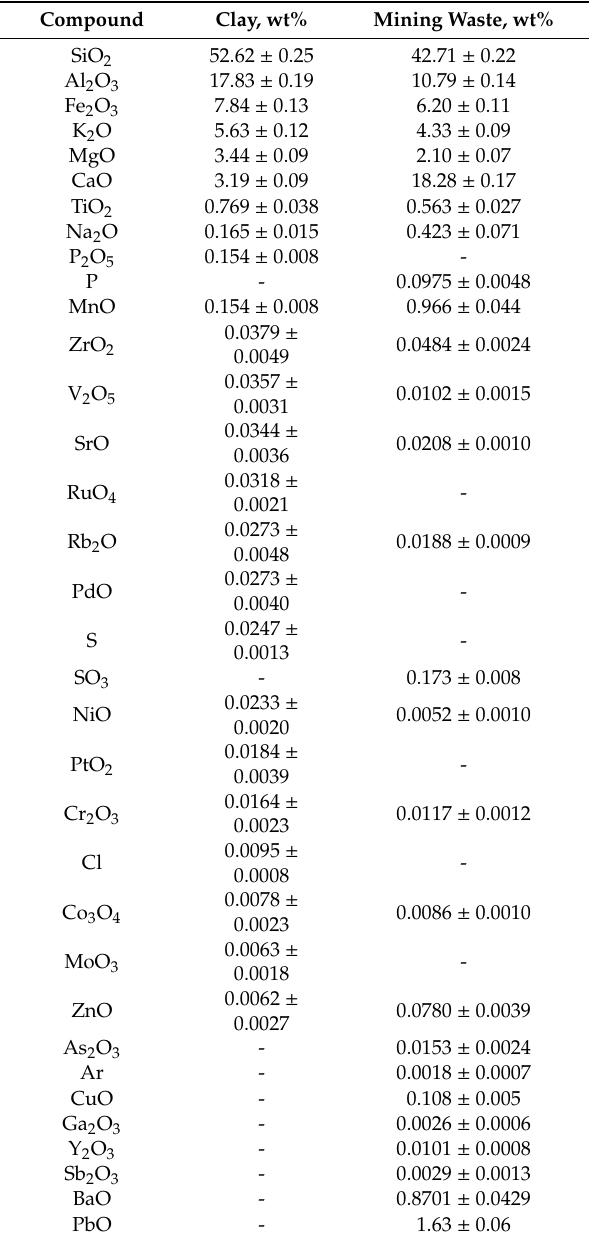
Table 4. X-ray fluorescence of the clay and minng waste